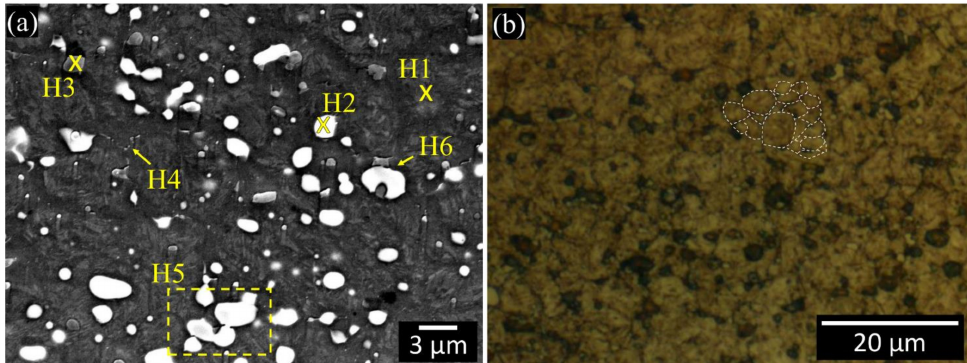
Figure 3. ( a ) FESEM microstructure of the cross-sectional view of the HSS base material after chemo-mechanical polishing. The crosses indicate pointwise EDS inspections; H1, H2, and H3 denote the martensite matrix, and the M 6 C and MC carbides, respectively; H4, H5 and H6 denote M 23 C 6 , similar M 6 C and dissimilar MC / M 6 C carbide clustering. ( b ) OM cross-sectional view of the HSS base microstructure after chemo-mechanical polishing and etching (Murakami’s etchant for 20 s and Nital agent for 20 s). The white dashed lines indicate the grain boundary structure.